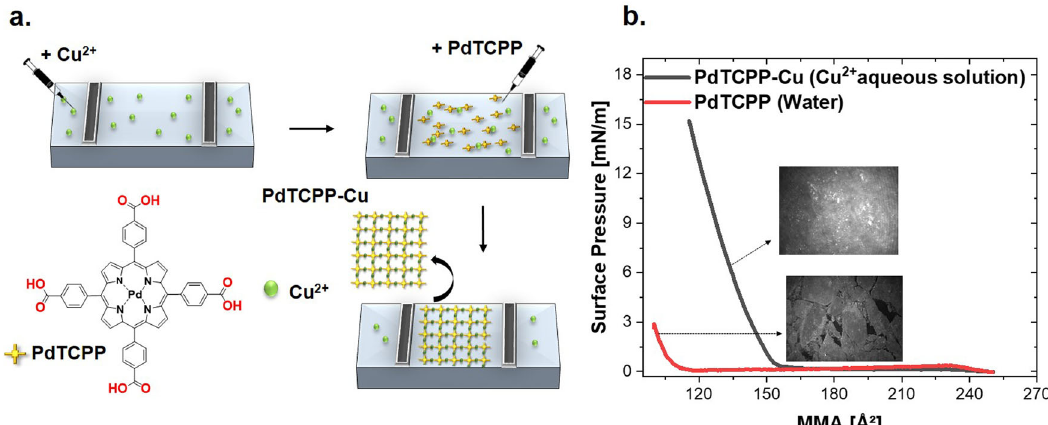
Fig. 1 Synthesis of 2D MOF at the Air − Water interface. a Schematic illustration of the representative assembly processes of PdTCPP-Cu at the air-water interface. The PdTCPP-Cu monolayer was prepared in a Langmuir trough by spreading the PdTCPP molecules onto an aqueous solution of Cu 2 + metal ions. b Surface pressure ( π ) versus mean molecular area (MMA) isotherm curves for PdTCPP monolayers in Cu 2 + aqueous solution (black line) and pure water (red line) as sub-phases. Inset shows the Brewster angle microscopy images of a packed monolayer of PdTCPP-Cu in Cu 2 + aqueous solution and assembly of PdTCPP monomer on the pure water